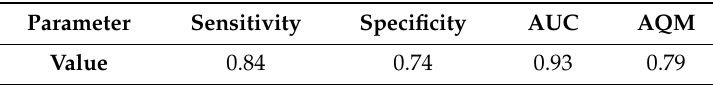
Figure 3. ROC Curve (Receiver Operating Characteristic Curve). Table 3. Parameters of the model.